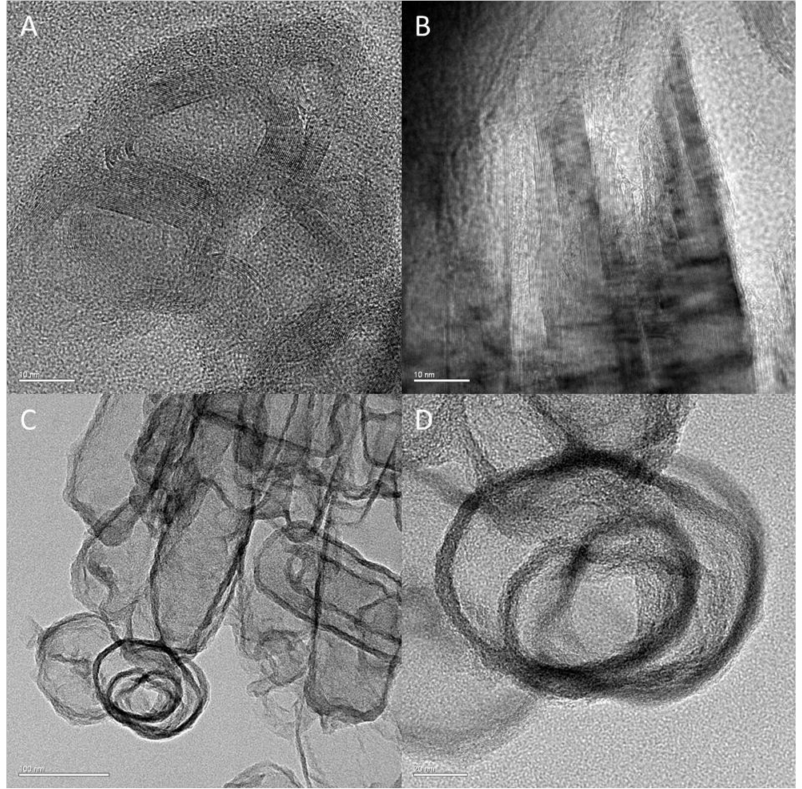
Figure 2. Transmission electron microscopy of samples calcined at ( A ): 100 ◦ C, ( B ): 200 ◦ C, and ( C , D ): 300 ◦